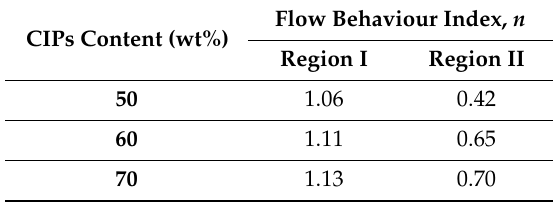
Table 2. The shear-thinning parameter, n , fitted based on the Herschel–Bulkley